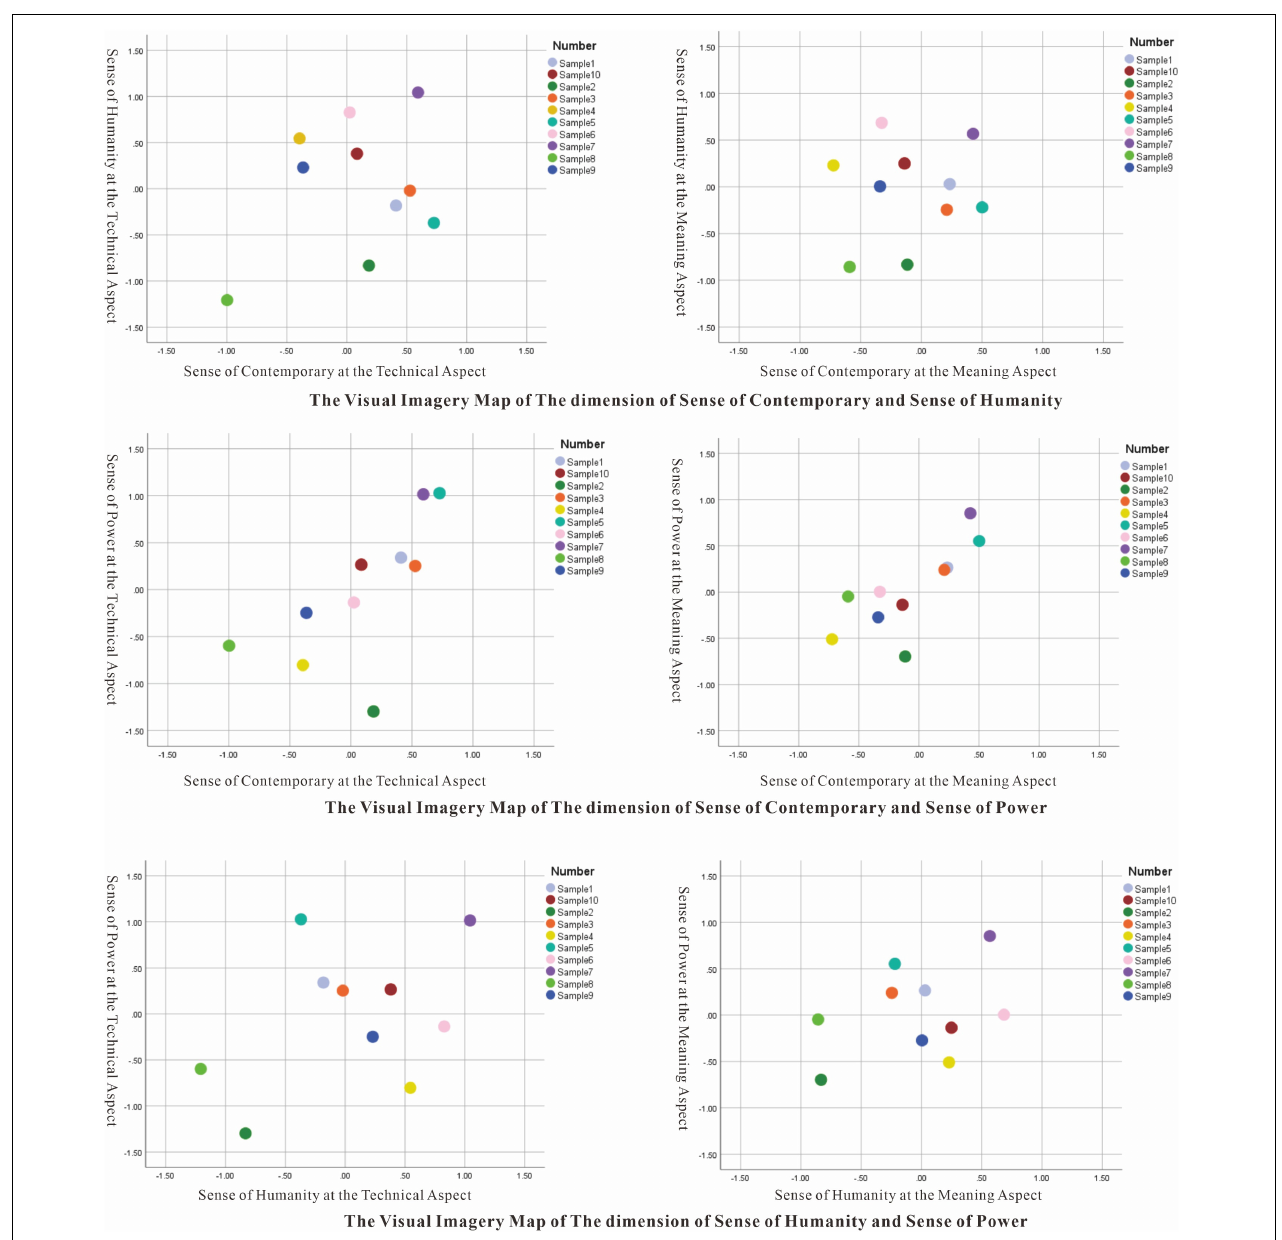
FIGURE 2 | Visual imagery map of the technical aspect and the meaning aspect (Poster source: